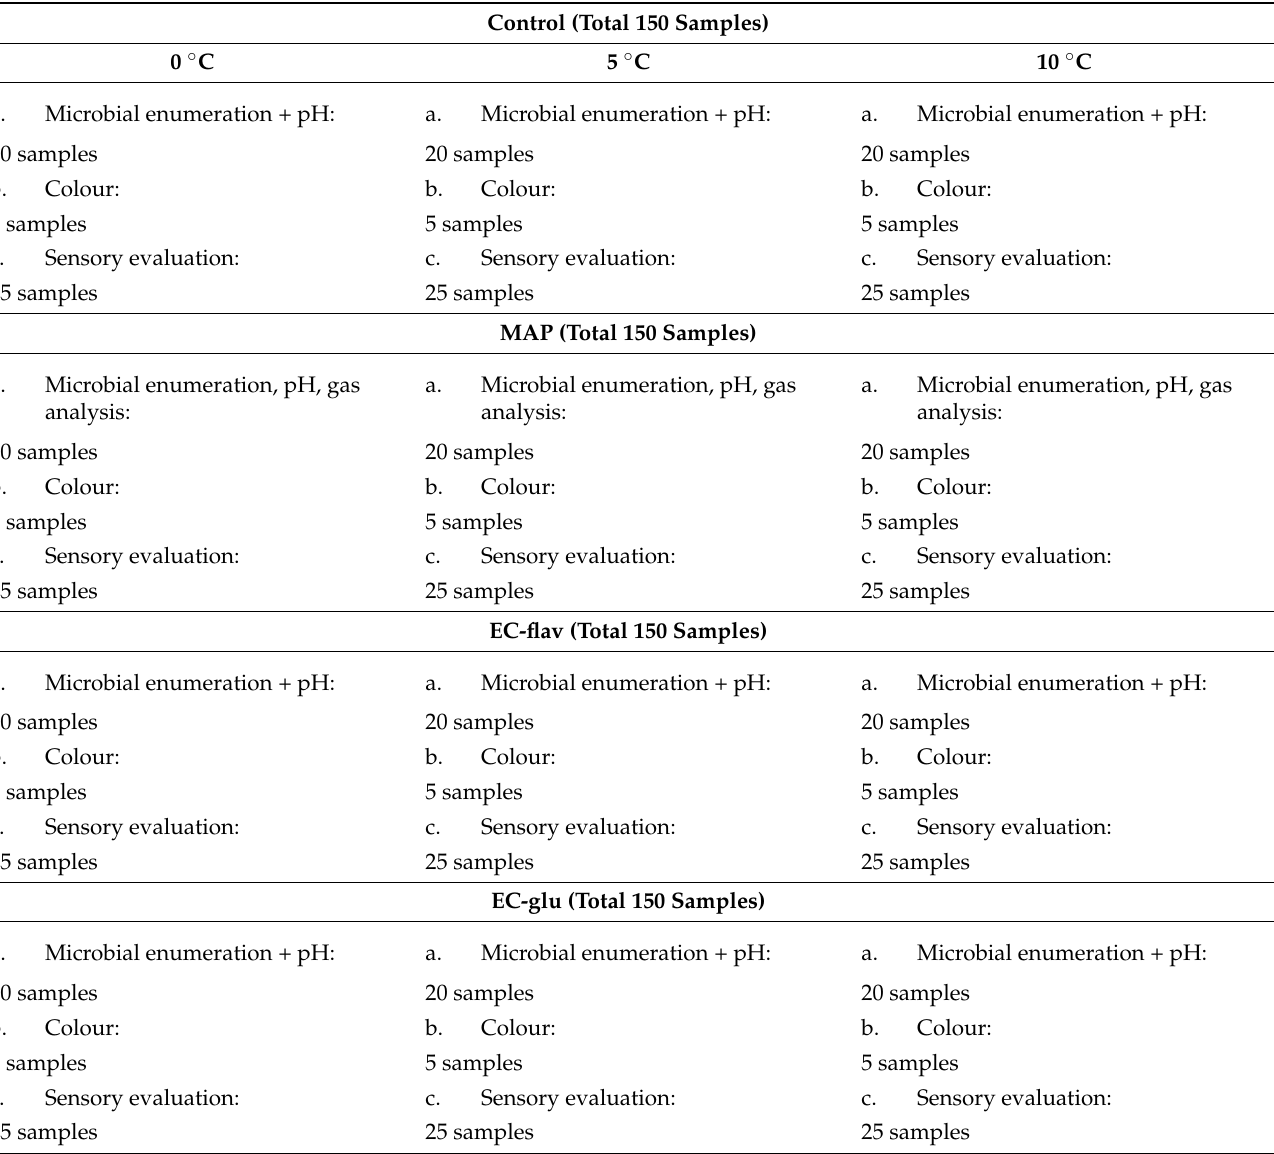
Table 1. Description of the experimental